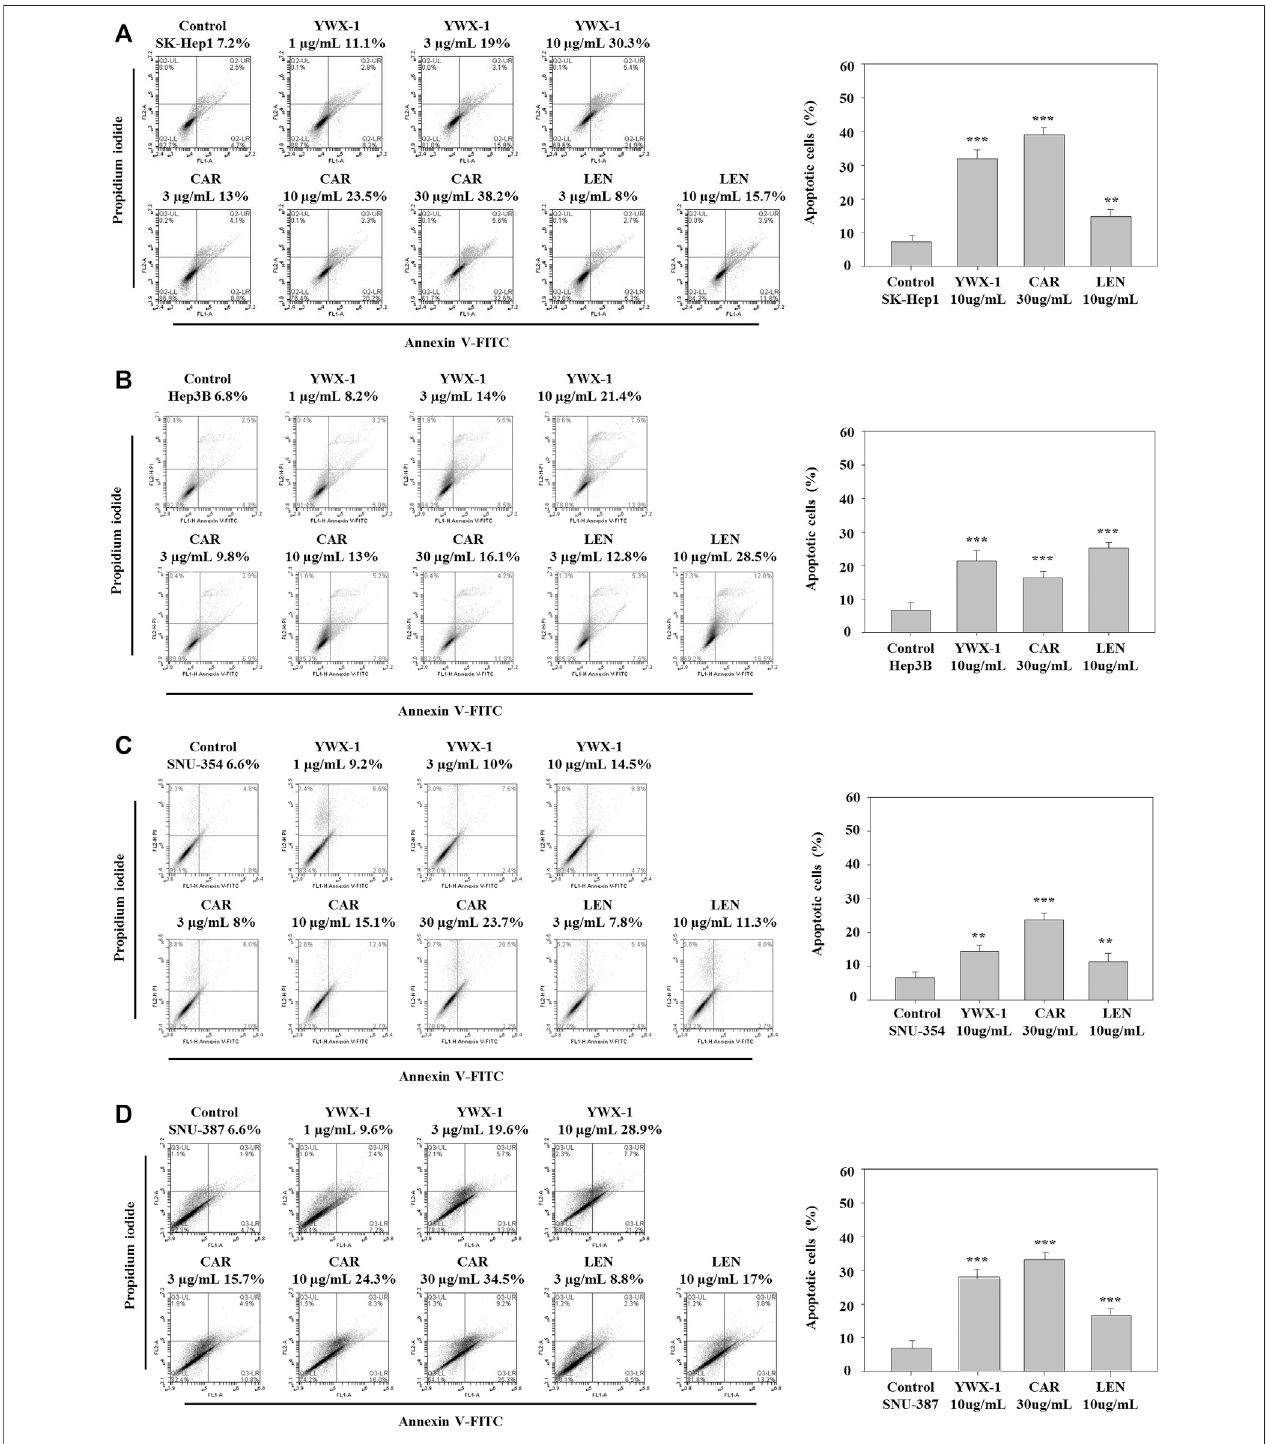
FIGURE6| Carrimycin(CAR) and monomeric isovalerylspiramycinI(YWX-1)promoteapoptosis ofhepatocellular carcinomacells. (A – D) SK-Hep1, Hep3B, SNU- 354, and SNU-387 cells were treated with different concentrations of carrimycin and monomeric isovalerylspiramycin I, and subsequently, the apoptotic cells were detected by Annexin V-FITC/PI double staining assay. The percentages of four hepatocellular carcinoma apoptotic cells were calculated. Statistically signi fi cant differences are indicated when compared with control group. Data represented as mean ± standard deviation of three independent experiments (n (cid:2) 3).